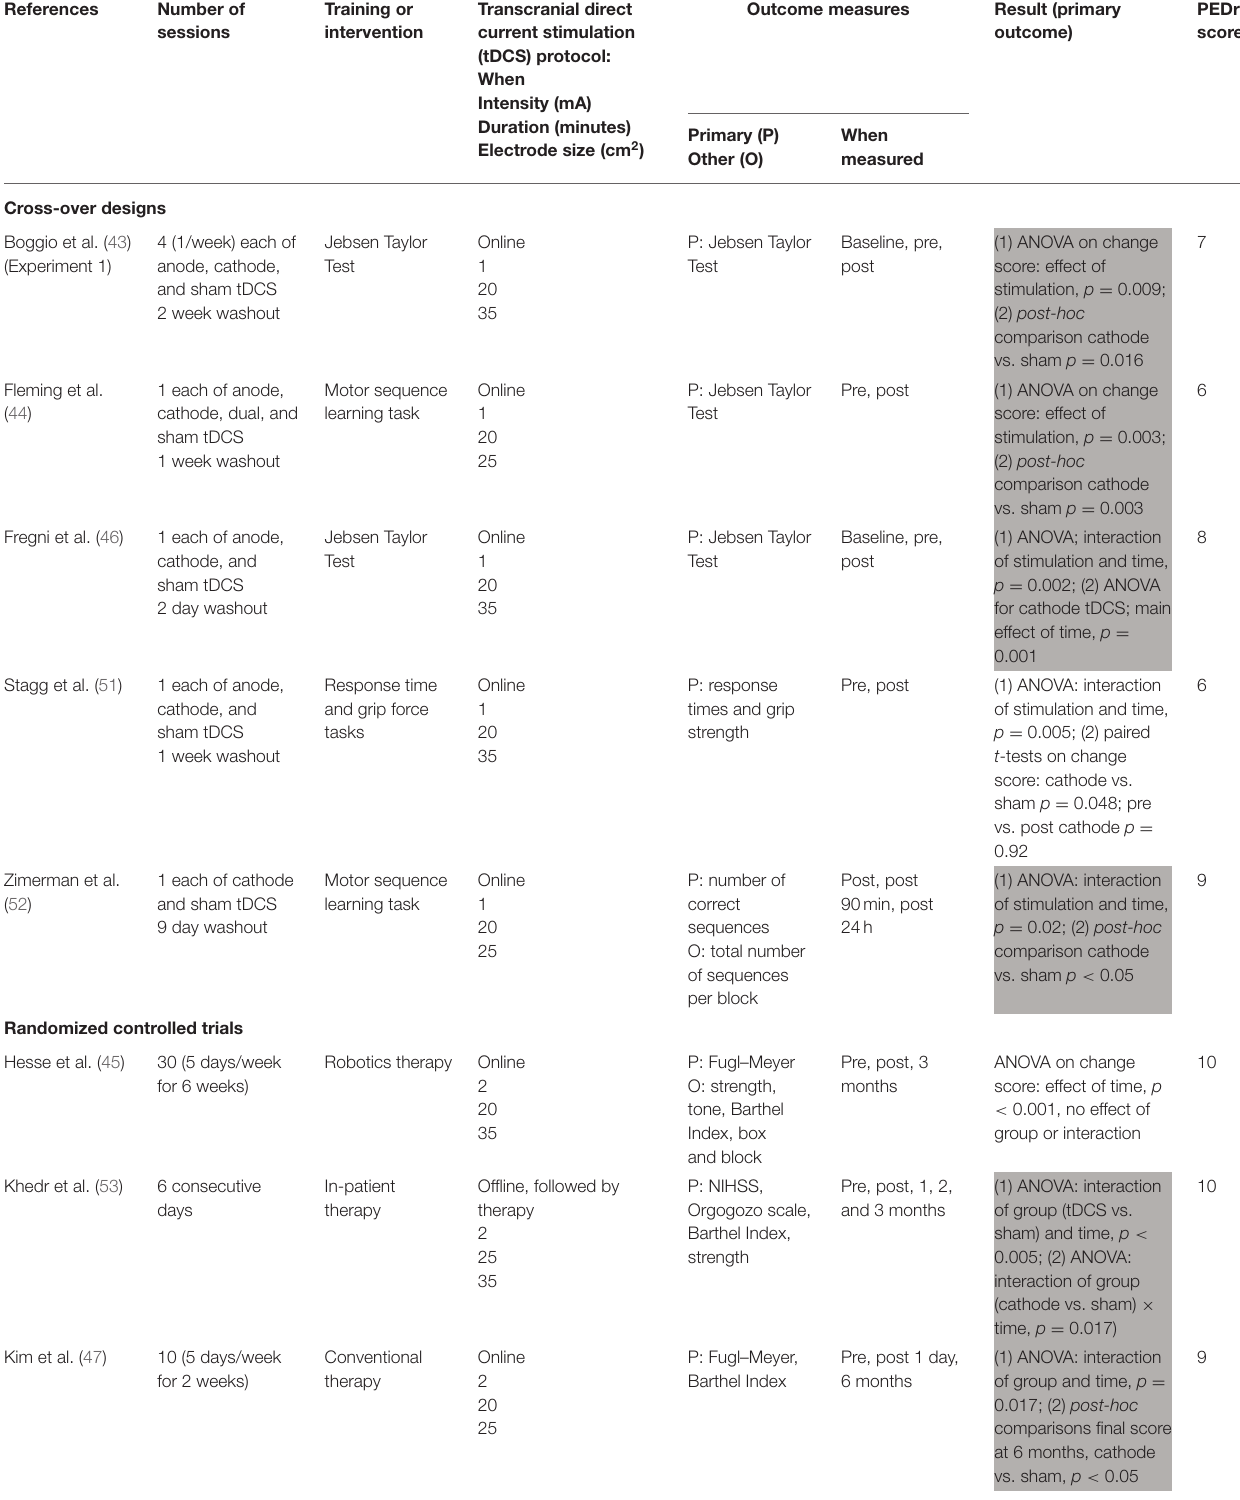
TABLE 4 | Study characteristics and